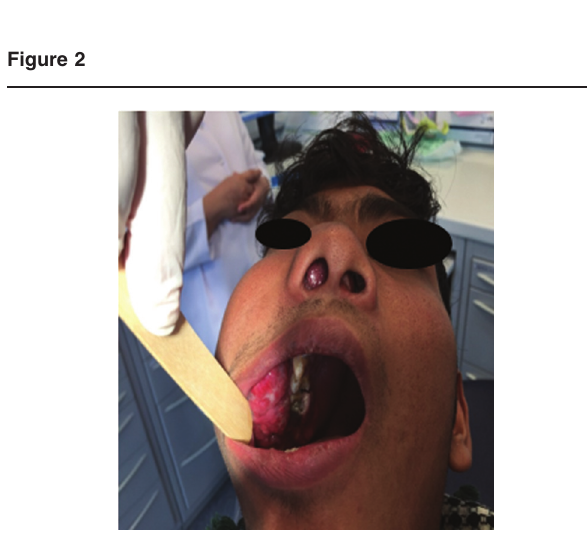
Facialdeformityandintraorallesionwithimpingementontheleftnostril.